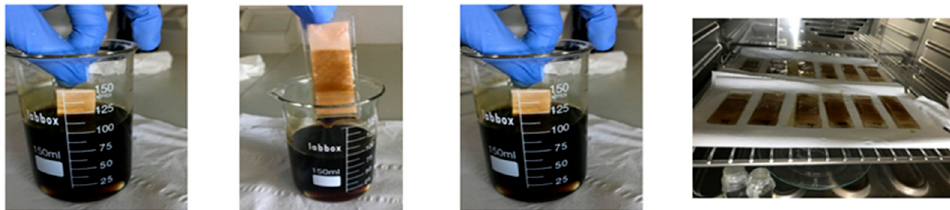
Figure 1. Plaster enhancement. From left to right: dipping in solution A for 30 s, taking out and turning 180°, dipping for additional 30 s and drying for 24 h at 40 °C.